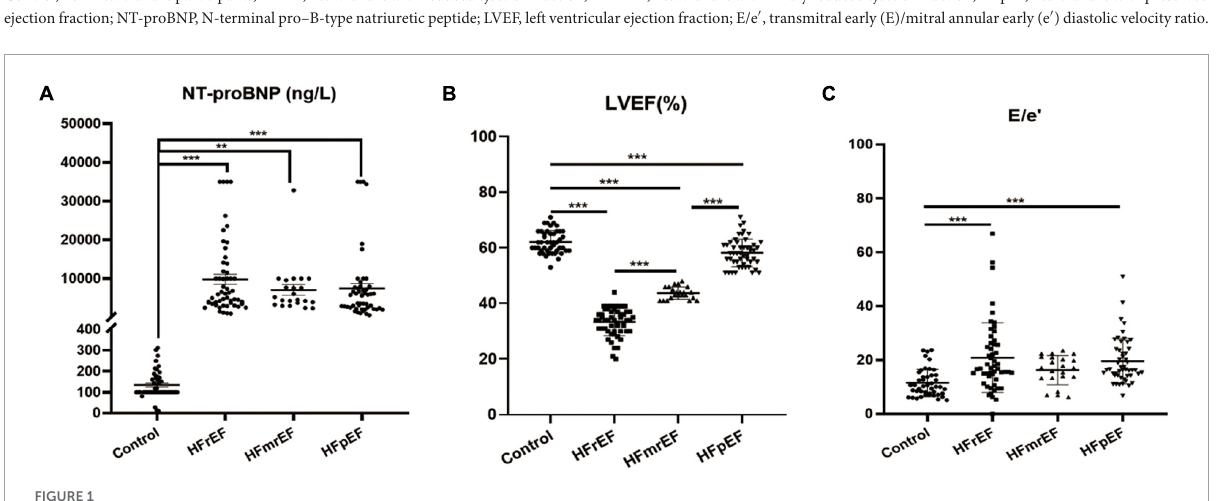
TABLE 2 Parameters in diagnosing different heart failure phenotypes. Characteristics